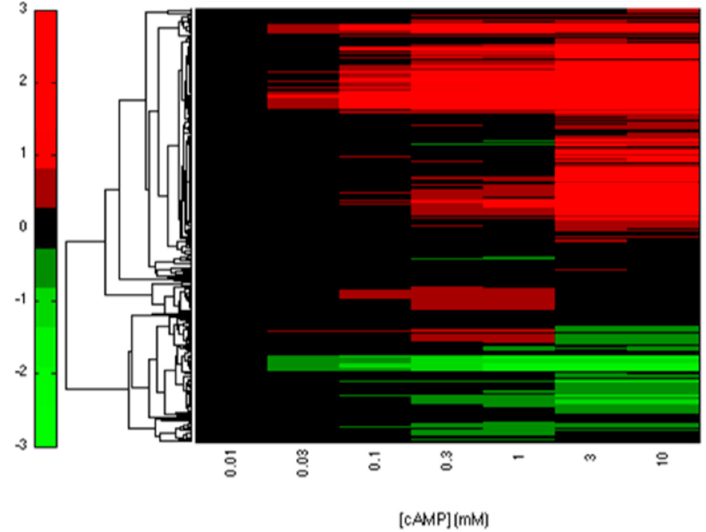
Figure 2. Heatmap of CRP-regulated genes. The clustering microarray data of the reported CRP-regulated genes are summarized in the heatmap. The expression profile of genes was used to construct CRP-FFLs for further analysis.